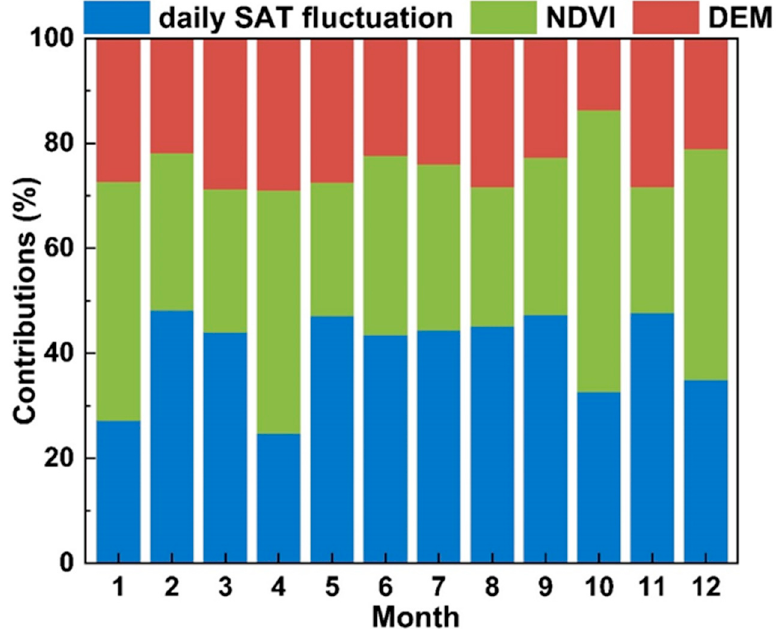
Figure 12. Monthly contributions of the LST ‐ related descriptors (including daily SAT fluctuation, NDVI, and DEM) for the ATC_GL in LST reconstruction.